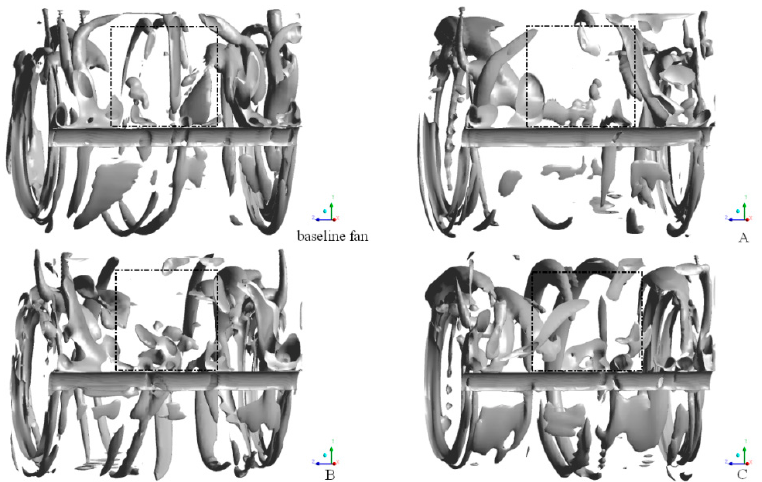
Figure 22. Three-dimensional distribution of vortices in volutes at Q / Q n = 0.483: ( A ) model-A; ( B ) model-B; ( C ) model-C.